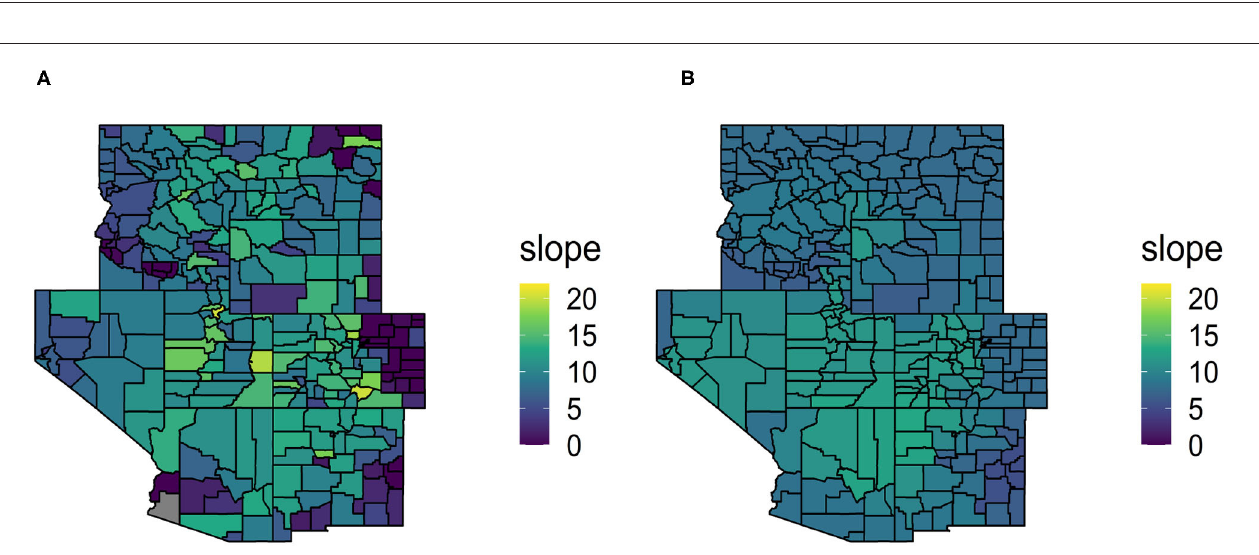
FIGURE 4 | A map of the relative efficiencies of the modified GREG to the GREGORY when estimating the average trees per acre for each county in the Interior West. Values above 1 indicate that the GREGORY is more efficient. Values greater than 2 were truncated to 2 to increase the readability of the map.